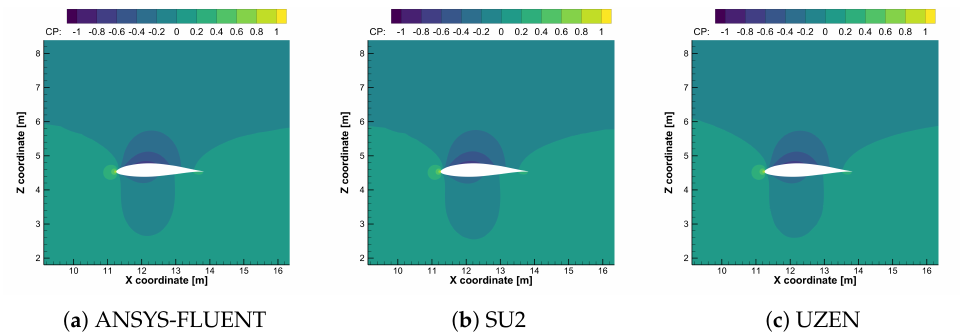
Figure 18. Pressure coefficient contour for power-off condition at α = 0 ◦ .